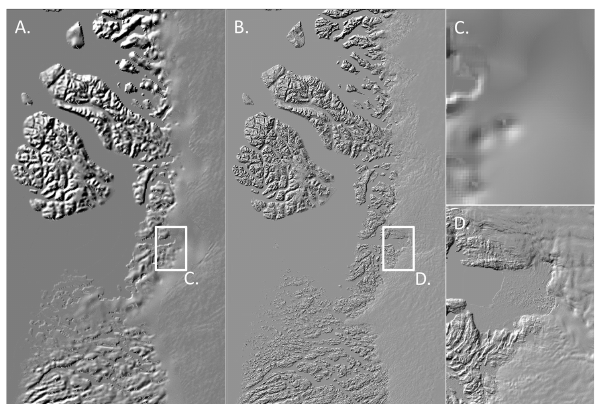
Figure 5. Hillshade representations of tile 1,2 (see Fig. 1) for the (a) PEB and (b) GIMP DEM showing the improvement in resolution of the margin and ice-free periphery. Enlargements over the front and fjord of Jakobshavn Isbræ for (c) PEB and (d) the GIMP DEM highlight the improvement in resolving outlet glacier termini and